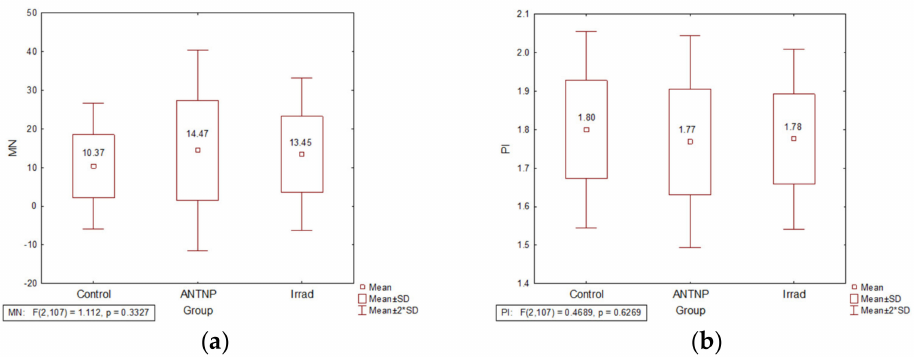
Figure 1. The impact of occupational exposure on DNA damage: ( a ) micronucleus frequency (number of micronuclei per 1000 examined binuclear cells); ( b ) proliferation index.